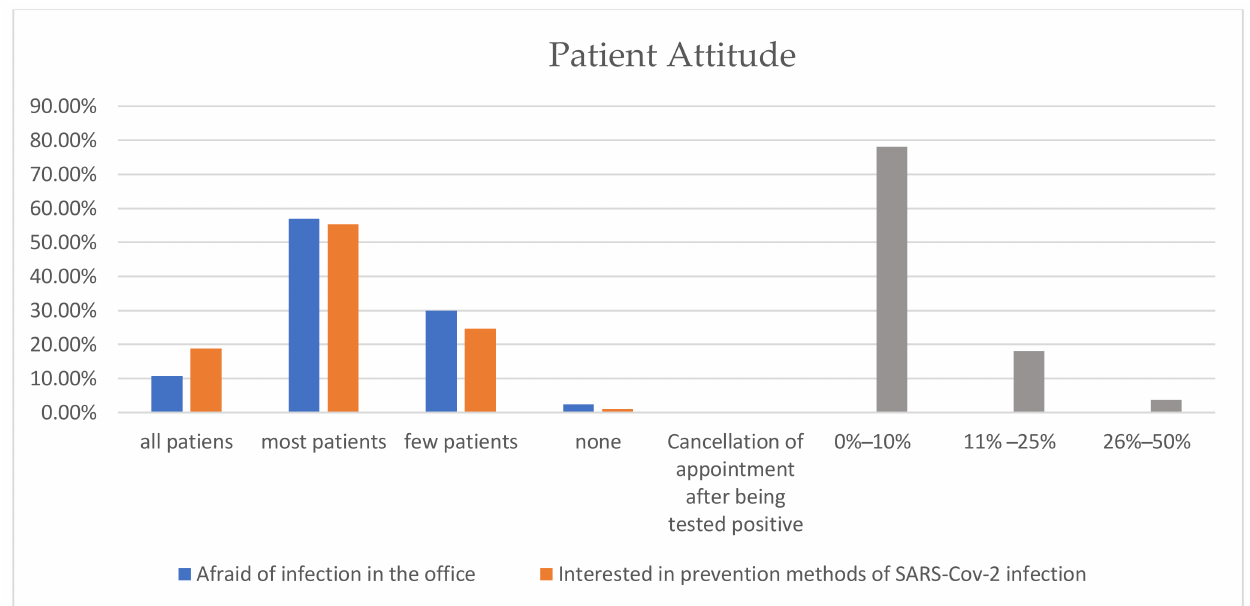
Figure 2. Patient attitude towards dental treatment during COVID-19 pandemic.